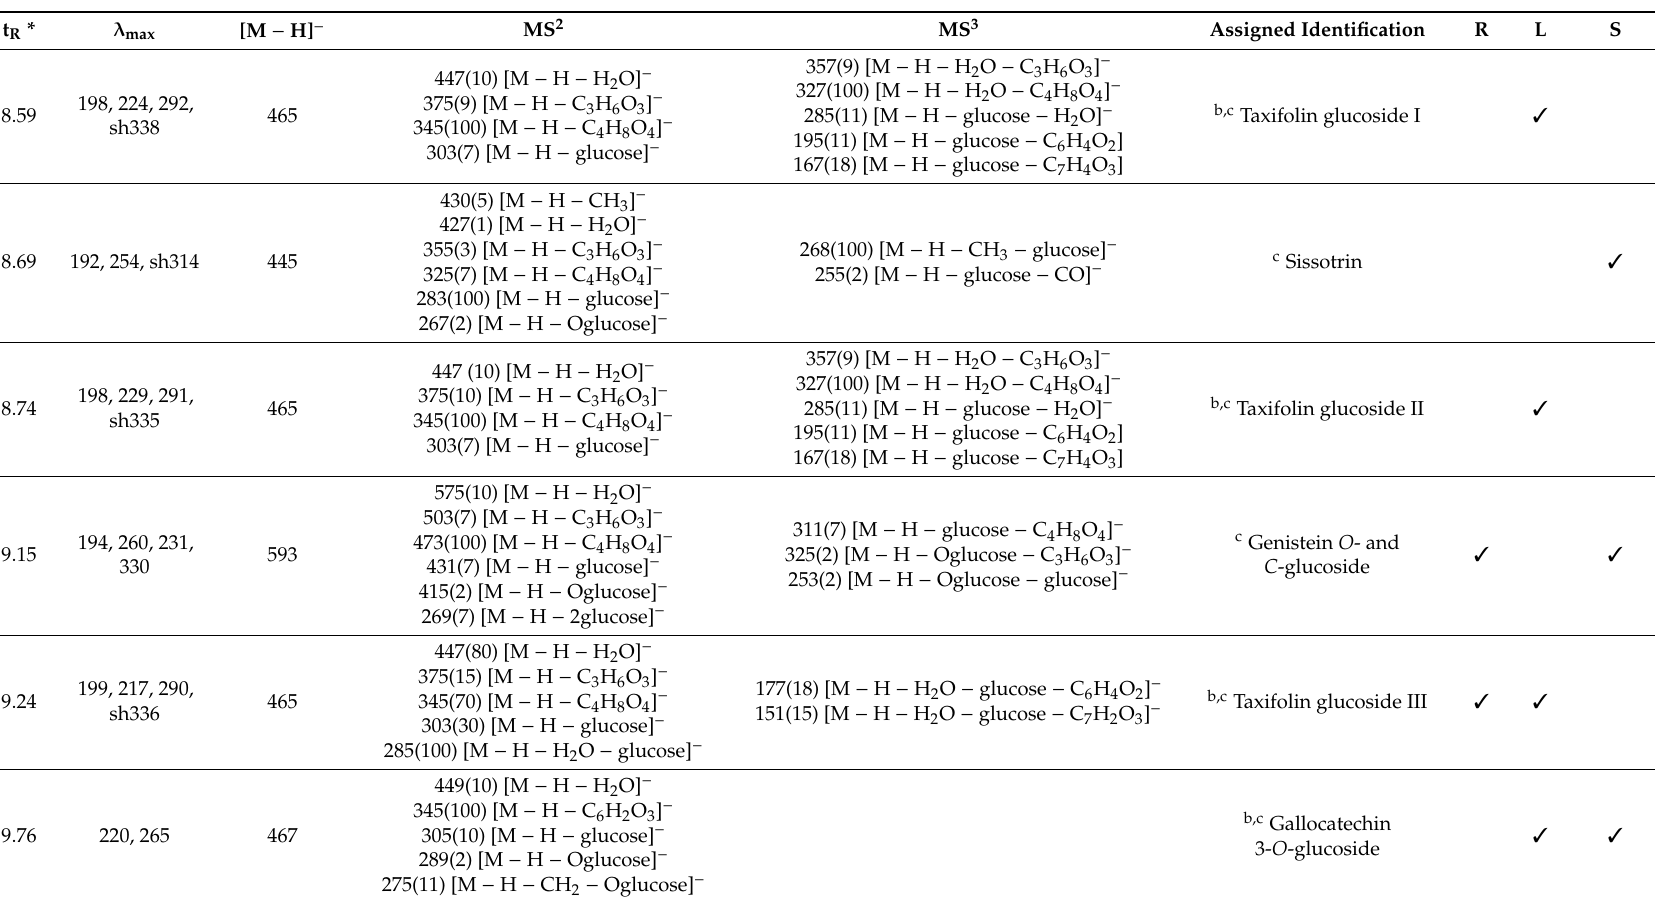
Table 1. Flavonoid composition of G. tridentata ethanolic extracts. Retention time (t R ; min.), wavelengths of maximum absorption in the visible region ( λ max ;